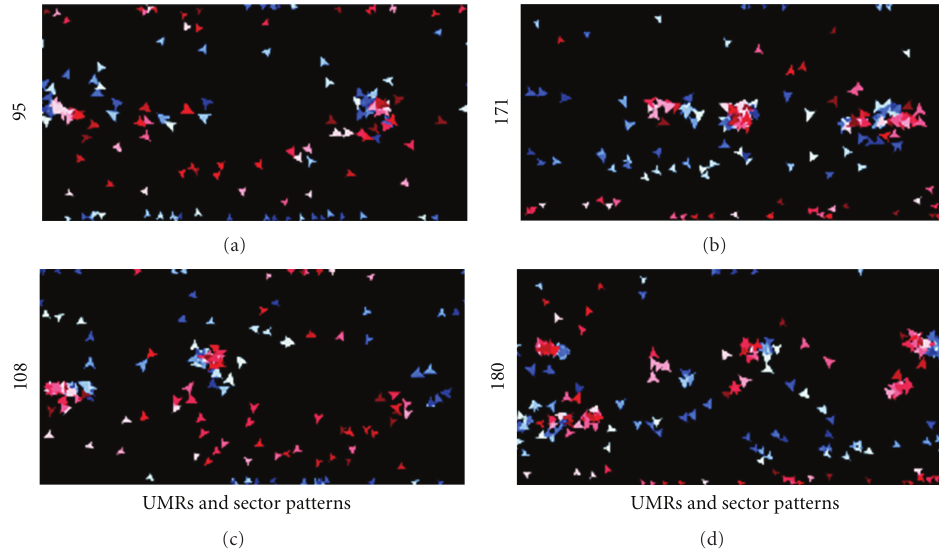
Figure 4: This figure illustrates that large-scale fields are able to mimic the observed Unipolar Magnetic Regions (UMRs) discussed by Bumba and Howard. We see a number of the “backwards C-shaped” field structures emanating from active regions as the Bipolar Magnetic Region’s (BMRs) fields disperse, break up, and drift to one pole or the other, driven by magnetic forces which underlie the Sun’s surface. The fields are swept backwards by di ff erential rotation as one may observe while watching the patterns evolve in time.